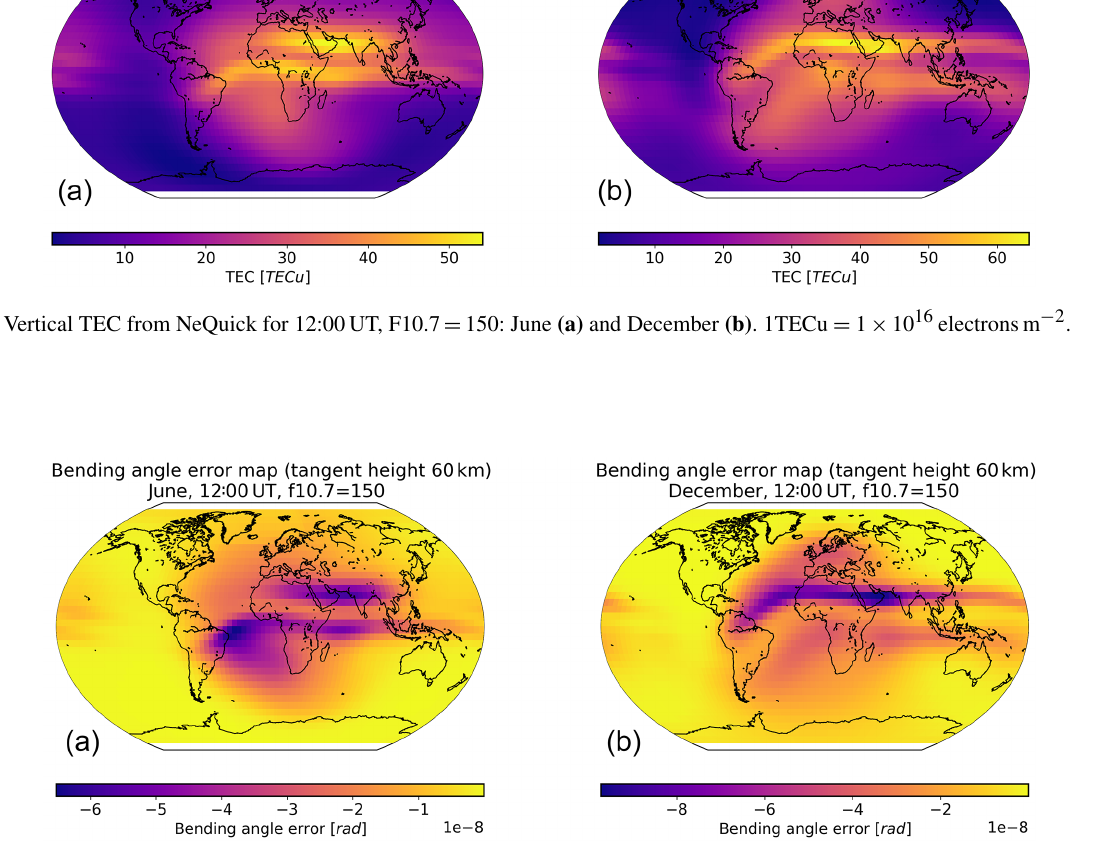
Figure 7. Estimated residual bending angle error for 12:00UT, F10.7 = 150: June (a) and December (b) .